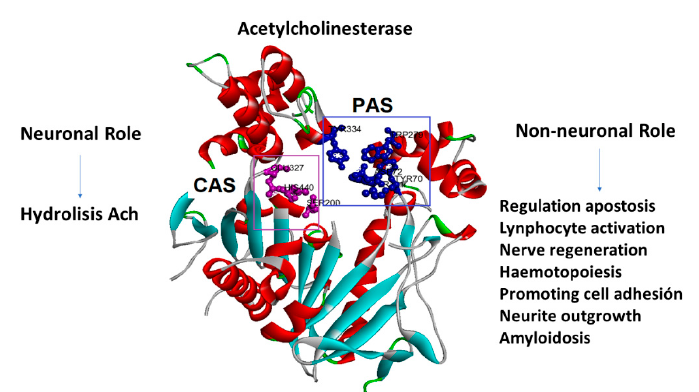
Figure 1. Acetylcholinesterase’s neuronal and non-neuronal roles. The amino acids that form the peripheral anionic site (PAS) are in blue, and the amino acids that form the catalytic site (CAS) are in purple.